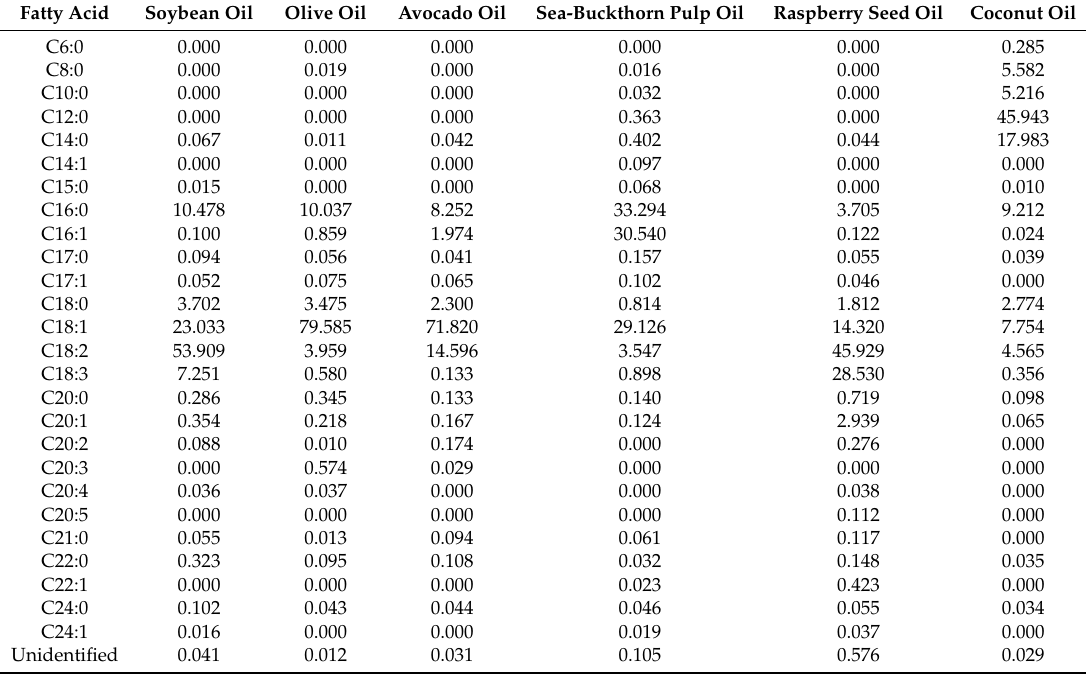
Table 1. Amounts of fatty acids expressed as percentages of total fatty acids methyl esters in natural oils. Fatty Acid